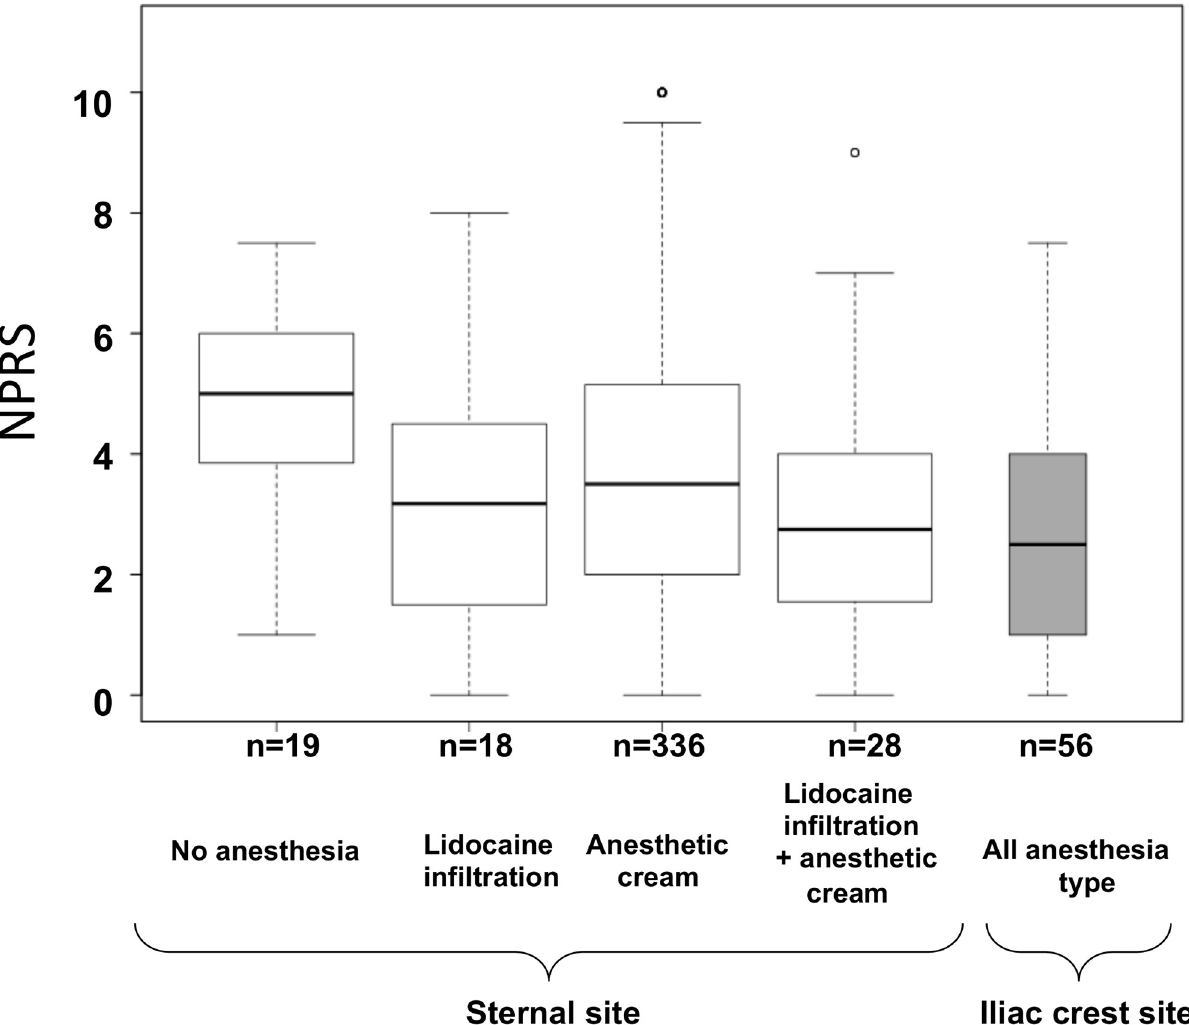
Fig 3. NPRS score according to BMA site and the anesthetic procedure. Boxplots represent median values (horizontal line) and whiskers the 5 th and 95 th percentiles. BMA: bone marrow aspiration; NPRS: numerical pain rating scale score.